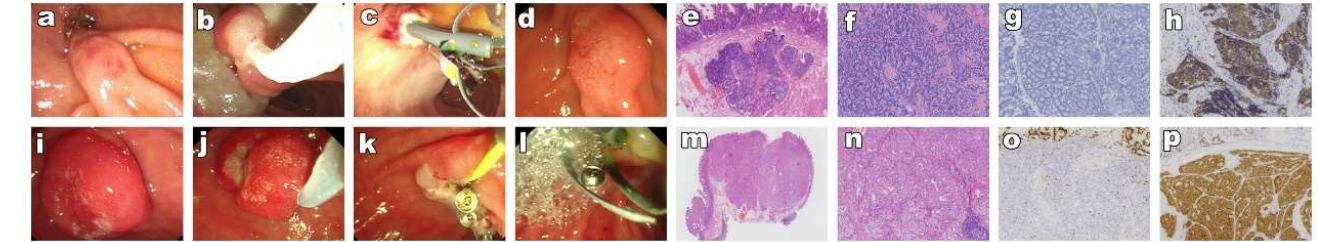
Figure 1. The typical cases of endoscopic papillectomy for ampullary neuroendocrine tumors. ( a ) The endoscopic morphology of case 5 (Table 1). ( b ) The tumor was removed by an endoloop (Case